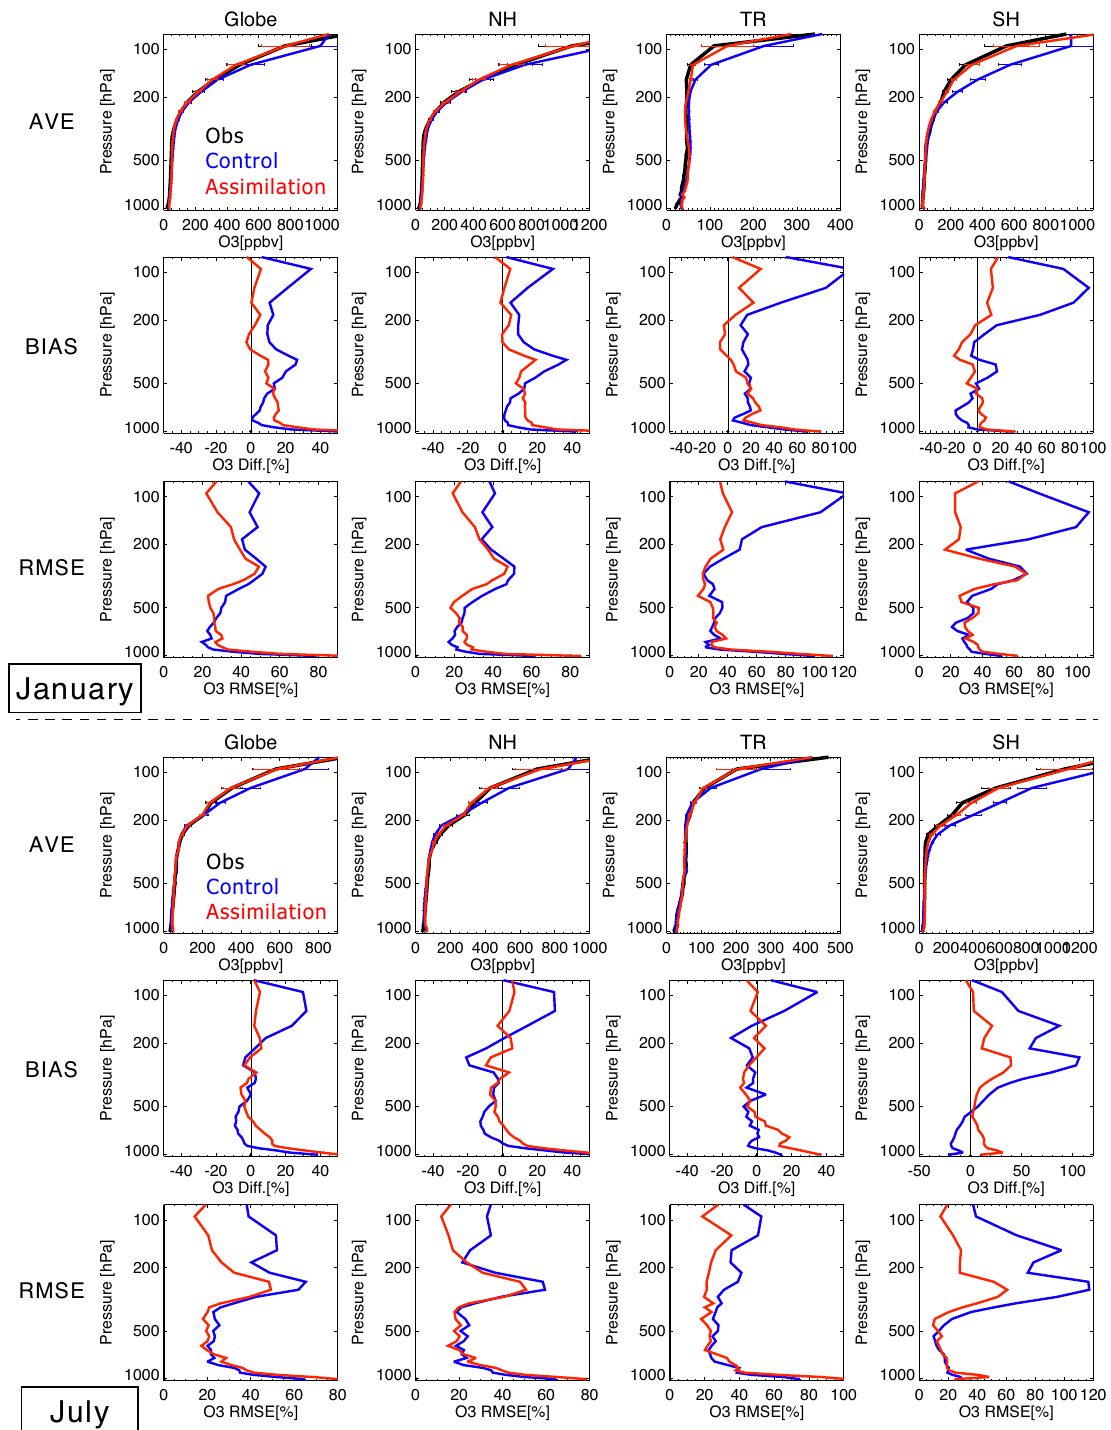
Fig. 11. Comparison of the vertical O 3 profiles between ozonesondes (black), the control run (blue), and the data assimilation (red) during 7–30 January 2007 (upper 9 panels) and 7–30 July 2007 (lower 9 panels). Upper row of each panel shows the mean profile; center and lower rows of each panel show the mean difference and the RMSE between the control run (the data assimilation run) and ozonesondes in blue